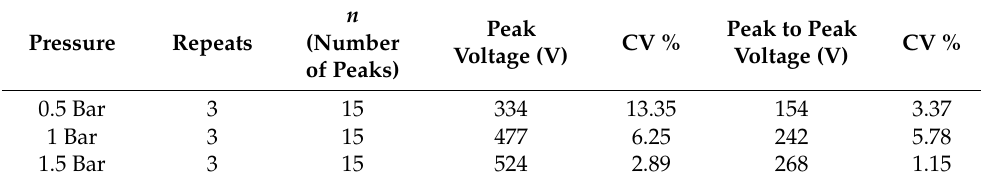
Table 3. The effect of the testing duration on the electrostatic charge generation.